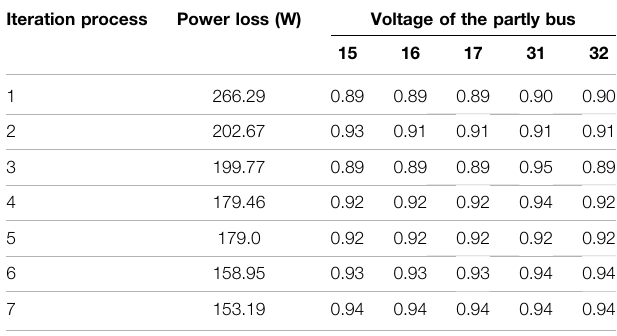
TABLE 2 | Iteration process of the AHSA, where the minimum power loss is 153.19 W. Iteration process